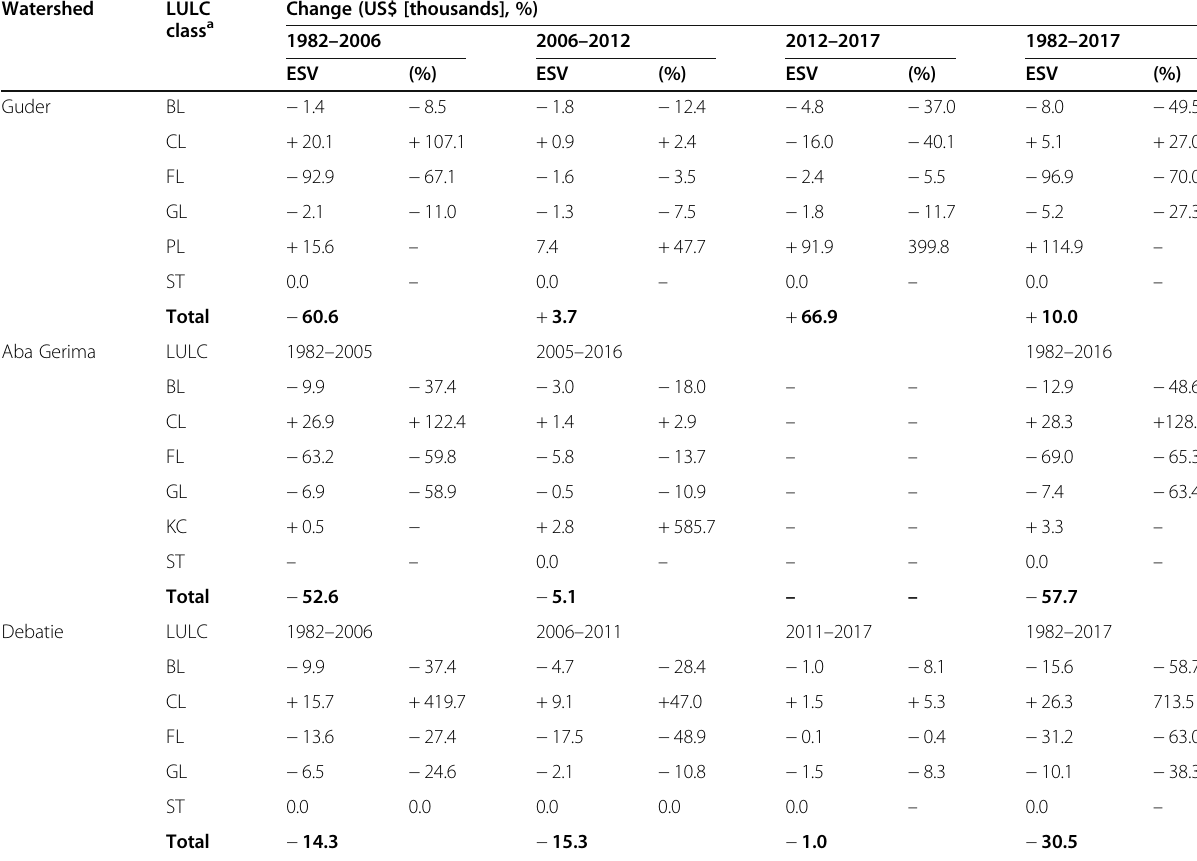
Table 4 Changes in ecosystem service value (ESV) (US$, %) between study years in Guder, Aba Gerima, and Debatie watersheds, Ethiopia. LULC abbreviations as defined in Table TS1